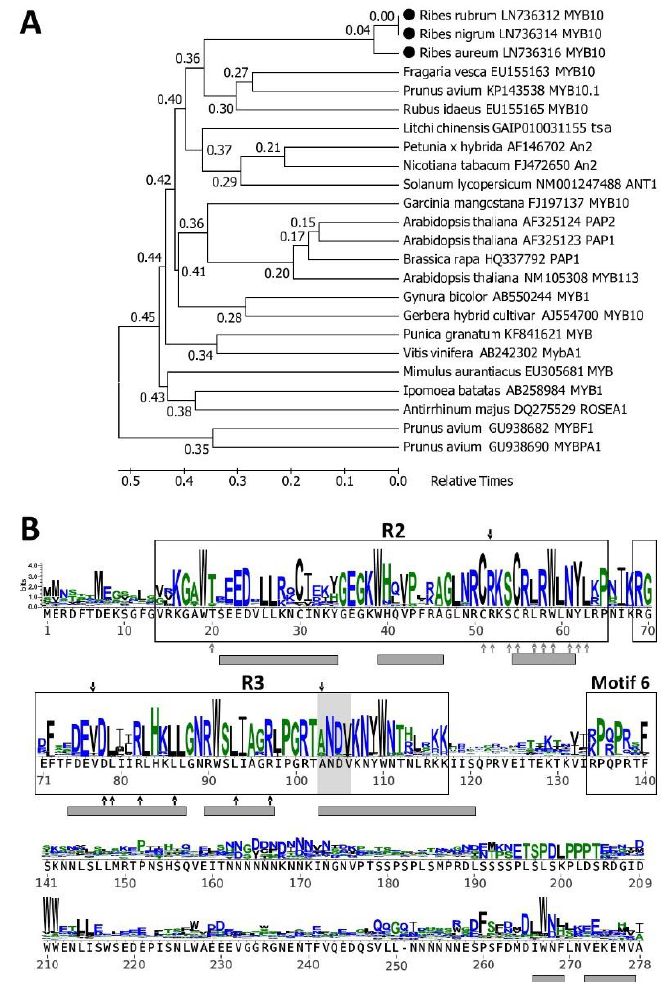
Figure 4. Similarity between Ribes MYB10 and other anthocyanin-inducing MYB proteins. ( A ) A phylogenetic timetree of selected anthocyanin-inducing MYB (MYB10-like) proteins. MYBF1 and MYBPA1 are non-MYB10-like, they activate flavanol- and proanthocyanidin-synthesizing enzymes, respectively. All proteins are named exactly the same way as described in the Figure 3 legend. ( B ) Sequence logo representing an alignment of 117 MYB10-like proteins from different species of the Pentapetalae taxonomic branch. Motif 6 (originally defined as KPRPR[S/T]F) is specific to subgroup 6 of the MYB proteins [27]. Gray background and black arrows on the top of the sequence denote amino acids specific to anthocyanin regulators [28]. Gray arrows point to amino acids important to DNA binding [29]. Black arrows under the sequence point to the motif ([DE]Lx2[RK]x3Lx6Lx3R) involved in interaction with bHLH proteins [30]. Other annotations are the same as described in the Figure 3 legend.